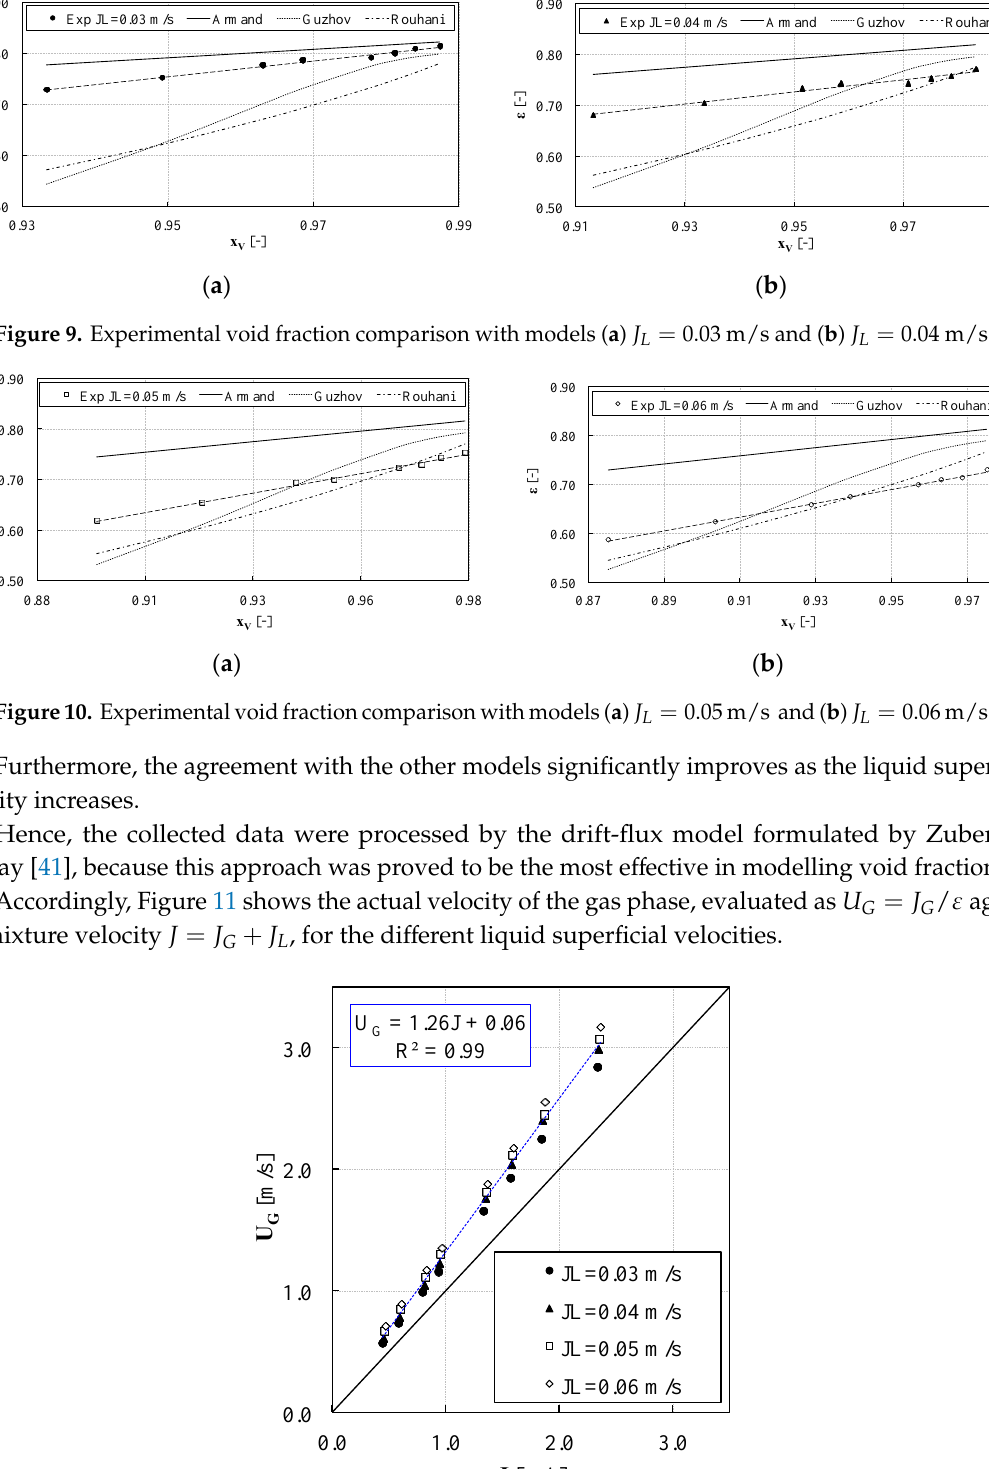
Figure 11. Effective gas velocity vs. average mixture superficial velocity. Figure 11. E ff ective gas velocity vs. average mixture superficial